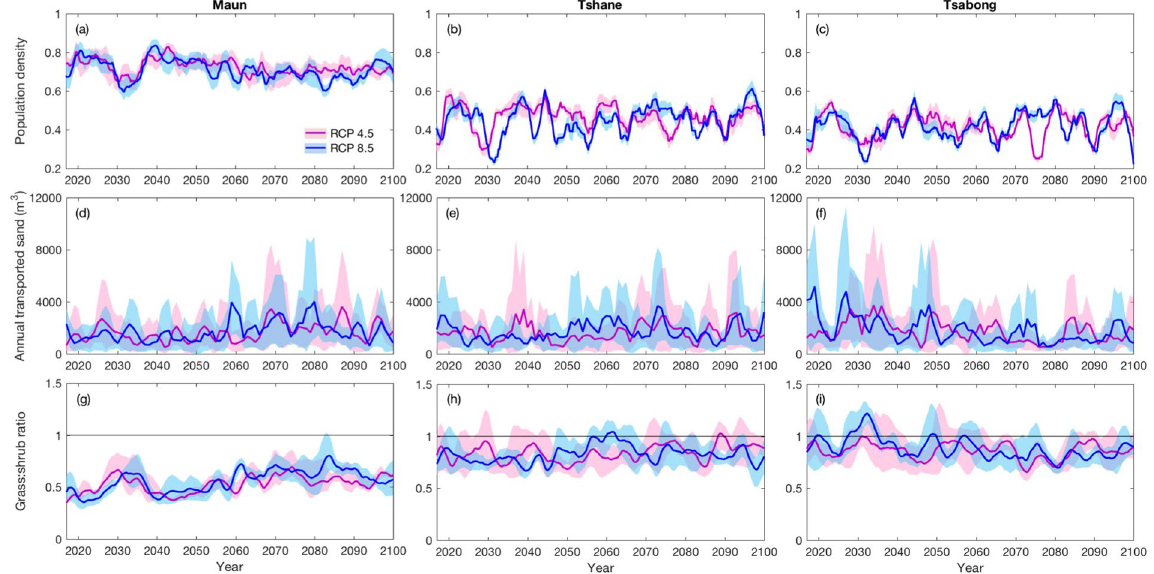
Figure 4. Landscape characteristics during the transient model runs, from 2017 to 2100, at the three study sites. Results are shown for RCP 4.5 (pink) and RCP 8.5 (blue) scenarios. Landscape characteristics: ( a , b , c ) population density; ( d , e , f ) total annual sand transport across the domain; ( g,h,i ) grass:shrub ratio, where values above unity represent grass dominance, and values below unity represent shrub dominance. Model was run 10 times per site and RCP from the year 1960, using projected precipitation data with random variation based on 5-year moving averages of seasonal standard deviations. 20 wind events occurred every 3 months, over a grid of 150 × 150 cells. The domain was randomly initiated with vegetation cover and species proportions observed at the end of an equilibrium run for 1960. Landscape characteristics are shown as three-year moving averages (solid coloured lines). Shaded area shows the range of model output across the 10 model runs for each site and